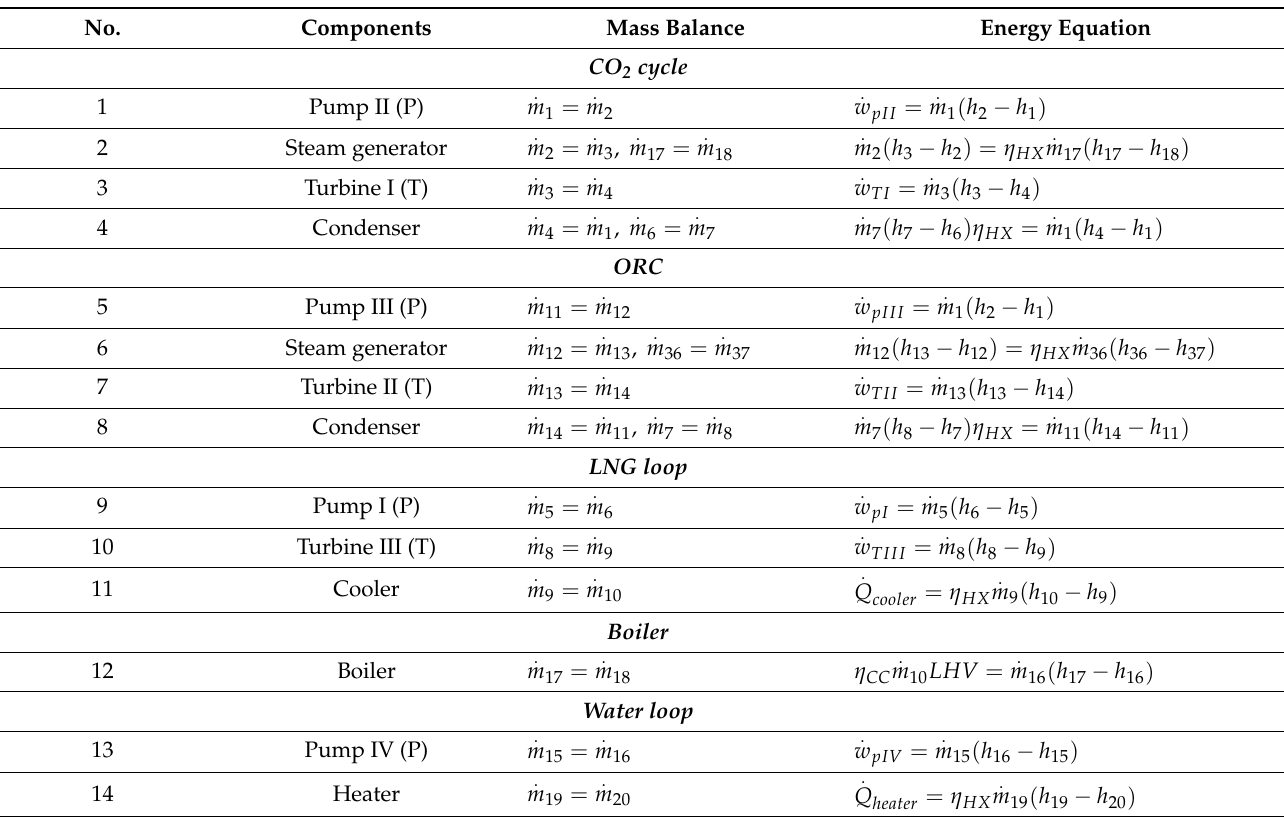
Table 2. Mass and energy balance relationships for the CO 2 cycle, ORC, LNG and water loops, and boiler.